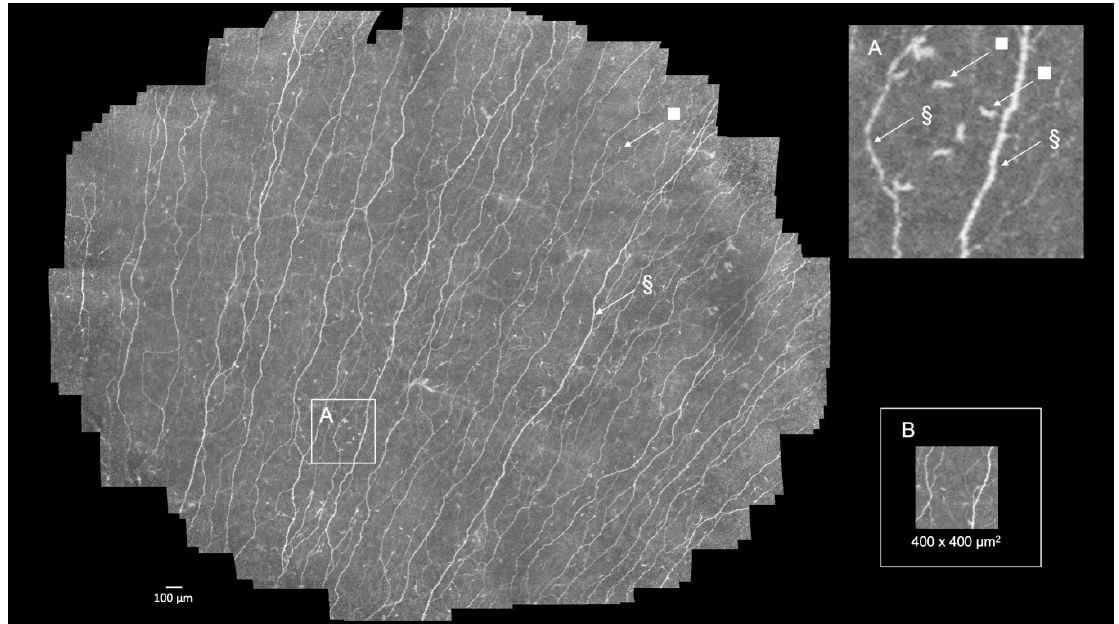
Figure 1. Normal subbasal nerve plexus (SNP) of a healthy volunteer obtained from a 55-year-old male using large-area confocal laser scanning microscopy (CLSM). Numerous hyperintense subbasal nerves of varying diameters, many of which are associated with dendritic cells, are visible (§, nerves of the SNP, and , dendritic cell) (high-resolution image supplementary Figure S1). Inset ( A ): subbasal nerve (§) and dendritic cell ( ), and inset ( B ): single CLSM image (area 400 × 400 µm 2 ).